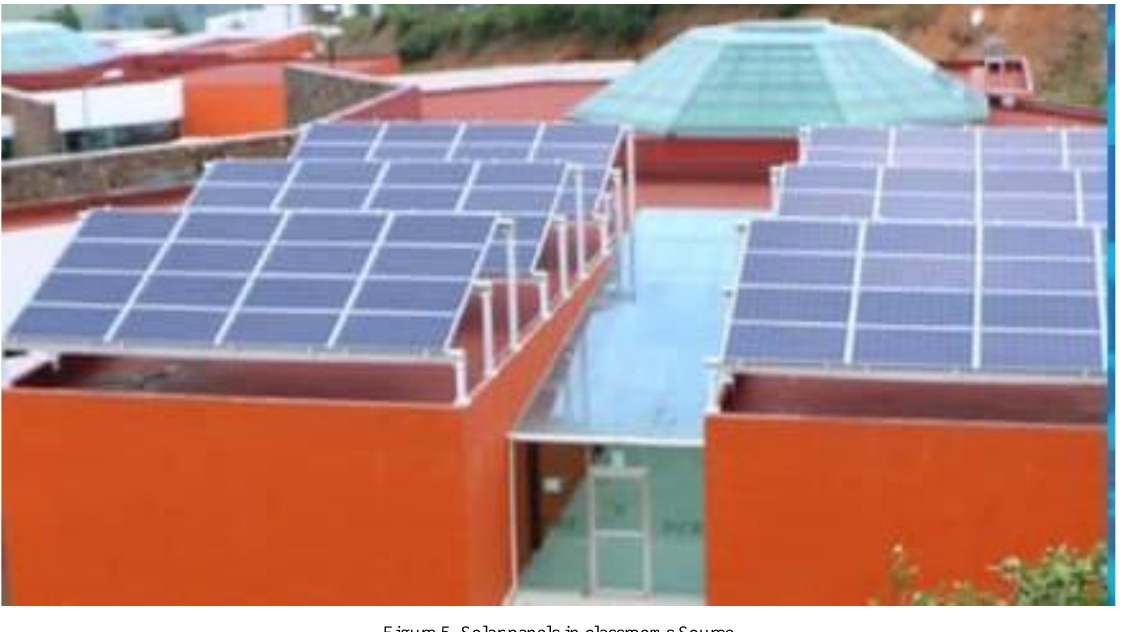
Figure 5, Solar panels in classrooms Source Source Obtained from the UICEH